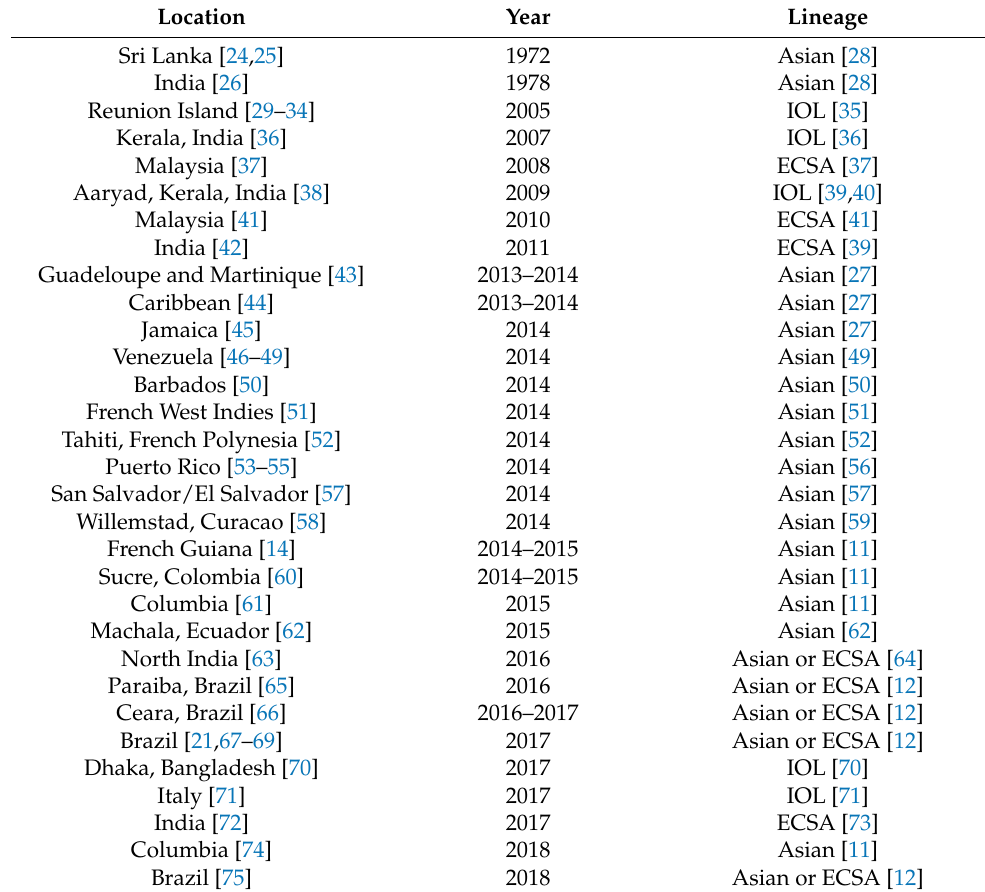
Table 1. Location and year of case studies in which altered cardiac status was reported. Strain information was taken from these case studies when available or taken from other sources reporting outbreaks in the same locations in the same